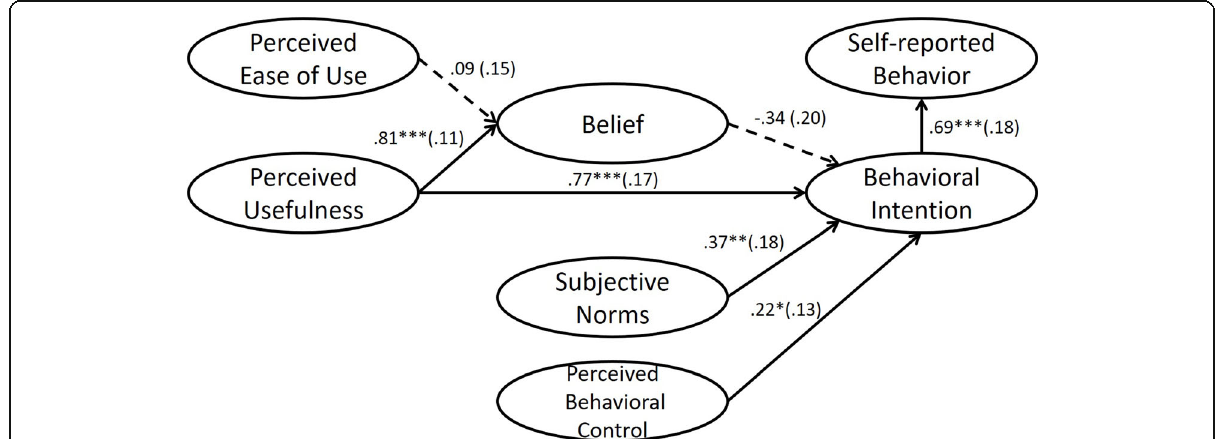
Fig. 13 The TTBIM for the PDP group ( n = 37). Solid lines indicate significant associations, and dotted lines indicate nonsignificant associations. Arrows indicate the direction of the relationships. Figures in parentheses represent the standard error ( SE ). *** p < .001; ** p < .01; * p <